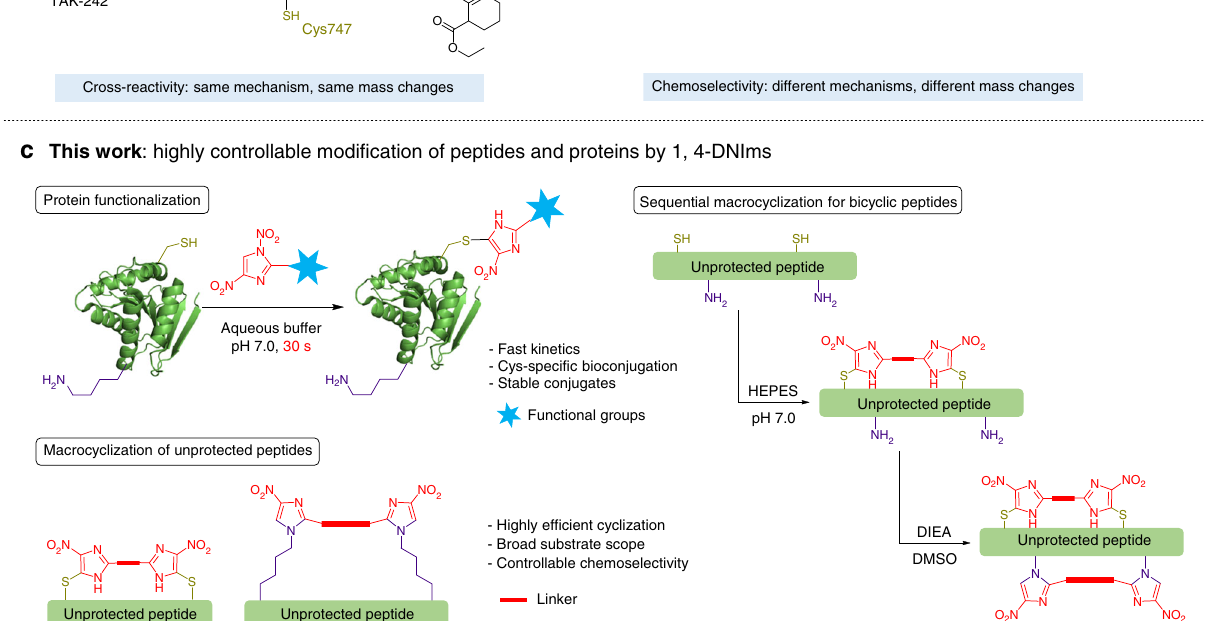
Fig. 1 1,4-Dinitroimidazoles as bifunctional bioconjugation reagents. a Cross-reactivity of cysteine and lysine modi fi cation reagents. b 1,4-DNIms react with cysteine and lysine through two distinct mechanisms and display different chemoselectivity under aqueous and organic solvents. c Application of 1,4- DNIms in protein functionalization and peptide